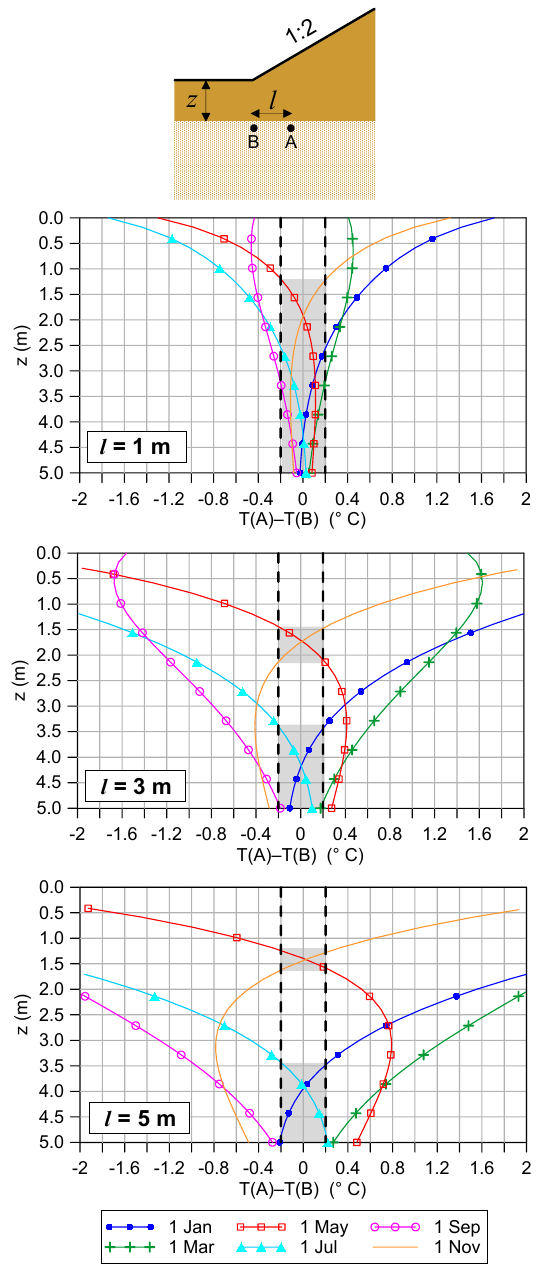
Figure 18. Temperature difference between a point at the toe of the dike ( B ) and a point under the dike ( A ) as a function of depth from ground level ( z) . Point A is located at a distance l = 1, 3 and 5m from the toe in the three graphs respectively. The regions of the graph where the temperature difference is smaller than 0.2 ◦ C (in absolute value) are highlighted by grey